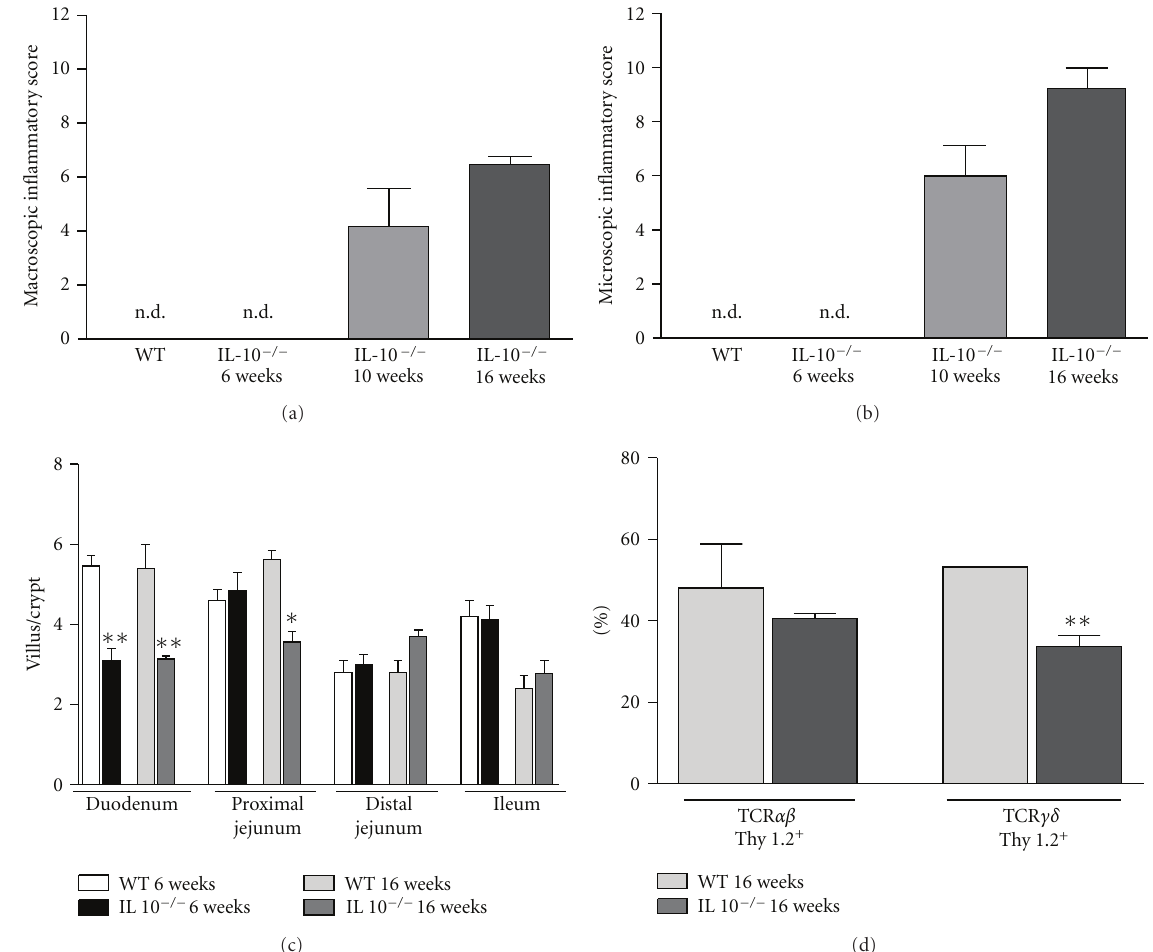
Figure 2: Inflammatory score of IL-10 − / − and IEL profile. (a) Macroscopic score of IL-10 − / − mice at 6, 10, or 16 weeks of age and control age-matched wild-type mice. (b) Microscopic score of IL-10 − / − mice at 6, 10, or 16 weeks of age and control age-matched wild-type mice obtained by histological analysis of the colonic tissues. (c) Villus/crypt ratio of duodenum, proximal jejunum, distal jejunum, and ileum of IL-10 − / − mice at 6, or 16 weeks of age. Bars represent the mean ± SEM of 5 mice per group. Asterisks represent di ff erences from age matched WT groups in the same intestinal segment ( ∗ P < 0 . 05 or ∗∗ P < 0 . 01). (d) Flow cytometry analysis with frequency of IEL isolated from 16-week-old IL-10 − / − and control mice stained with fluorescent antibodies to αβ TCR, γδ TCR, and Thy1.2. Cells were analyzed inside the total lymphocytes gate. Bars represent the mean ± SEM of 3 mice per group. Significant di ff erence ( ∗∗ P < 0 . 01) is indicated by the asterisk. n.d means non